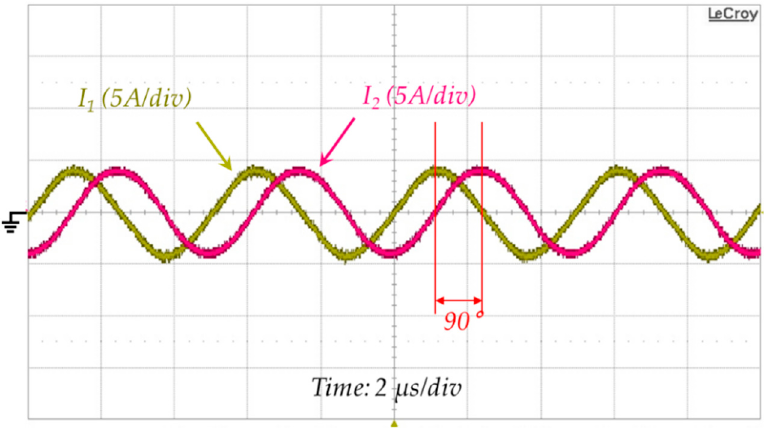
Figure 13. Experimental result: transmitter currents.